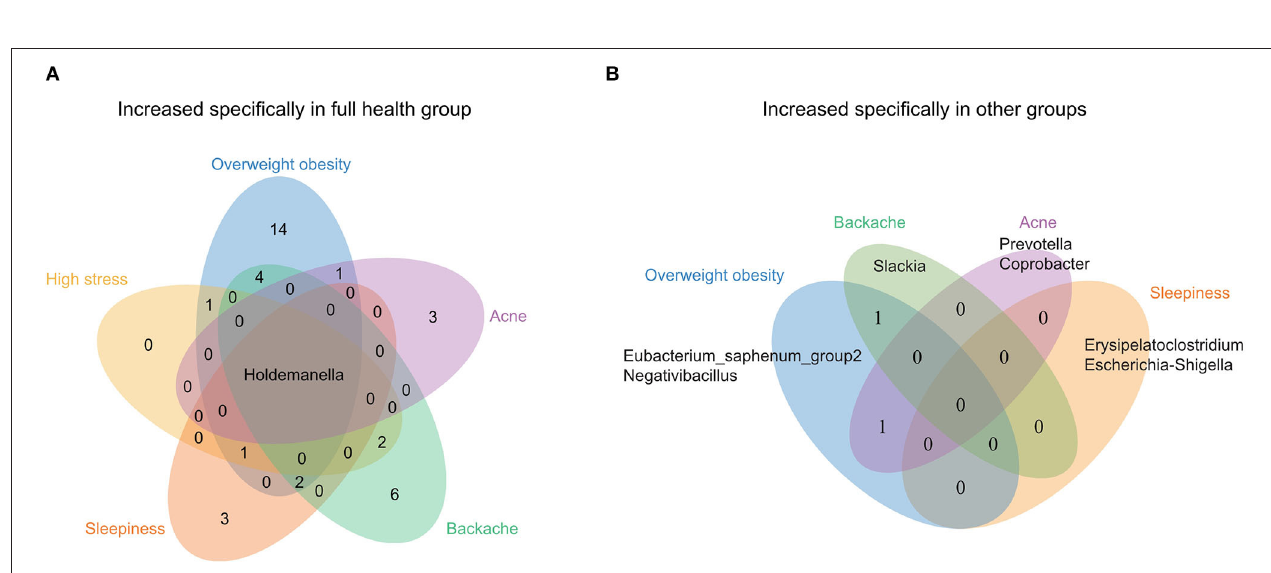
FIGURE 3 | Venn diagram of distinct genera identified by LEfSe analysis among each of the population groups in the OFWs cohort. (A) Distinct genera in the Full health group. (B) Distinct genera in the other groups (Overweight obesity, High stress, Sleepiness, Backache, and Acne).